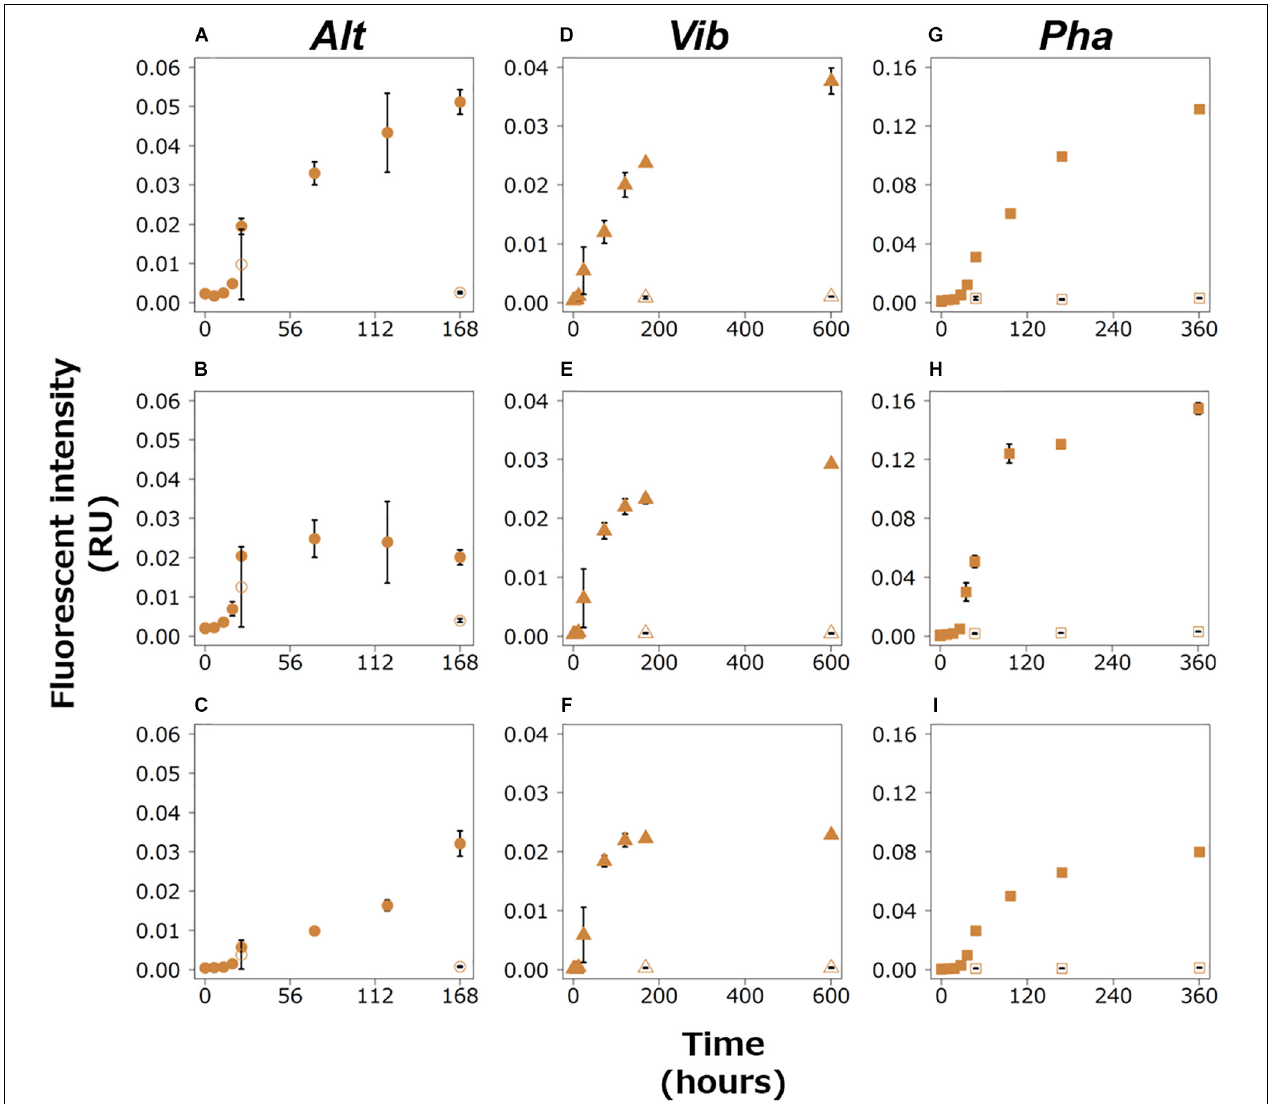
FIGURE 4 | Changes in the fluorescence intensities of peaks categorized as humic-like FDOM in the Alt (AH1, A ; AH2, B ; AH3, C ), Vib (VH1, D ; VH2, E ; VH3, F ), and Pha (PH1, G ; PH2, H ; PH3, I ) treatments. The closed and open symbols represent the experimental treatment and control treatment, respectively. The error bars indicate standard deviation of triplicate incubation